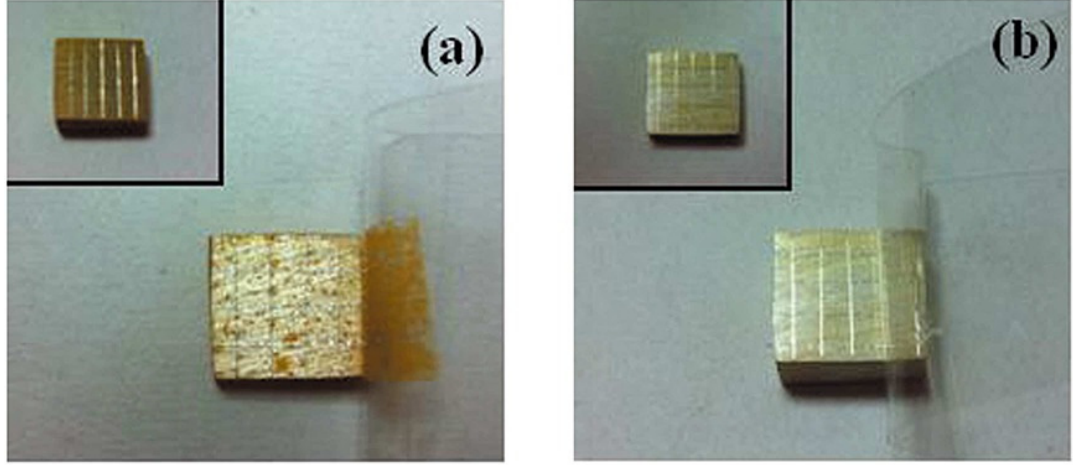
Figure 13. Optical photographs of ( a ) non-modified and ( b ) silane-modified cerium conversion coating before and after the cross cut tape test. Reprinted from [232] with permission from Wiley.